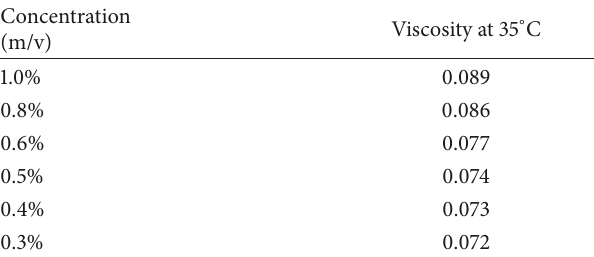
Table 2: Viscosity ( × 10 −1 Pa ⋅ s) of polyvinyl alcohol (PVA) at 35 ∘ C temperature and concentration at 1MHz frequency.